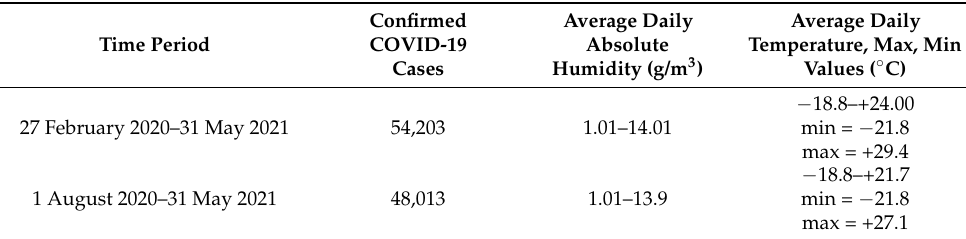
Table 1. An overview of COVID-19 cases and meteorological data during the two study periods. The total number of laboratory confirmed COVID-19 cases, range of the daily average absolute humidity, the range of the daily average temperature values and minimum and maximum temperatures for the two time periods are shown. Temperature and absolute humidity values were measured at the Kumpula weather